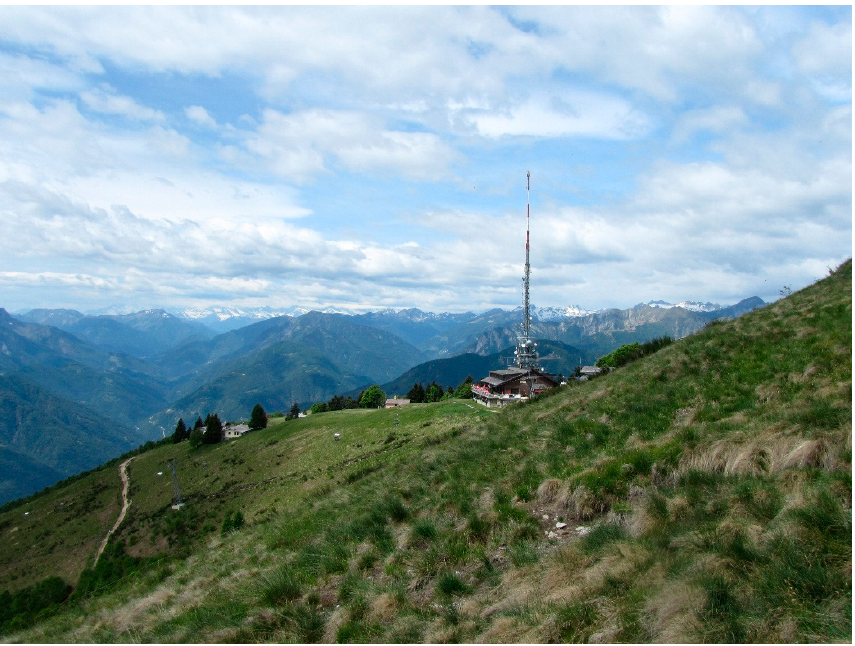
Figure 1. Morphology of the mountainous Cimetta backscattering radar bin: small cottages, the hut, the chairlift and the 90 m tall metallic tower.